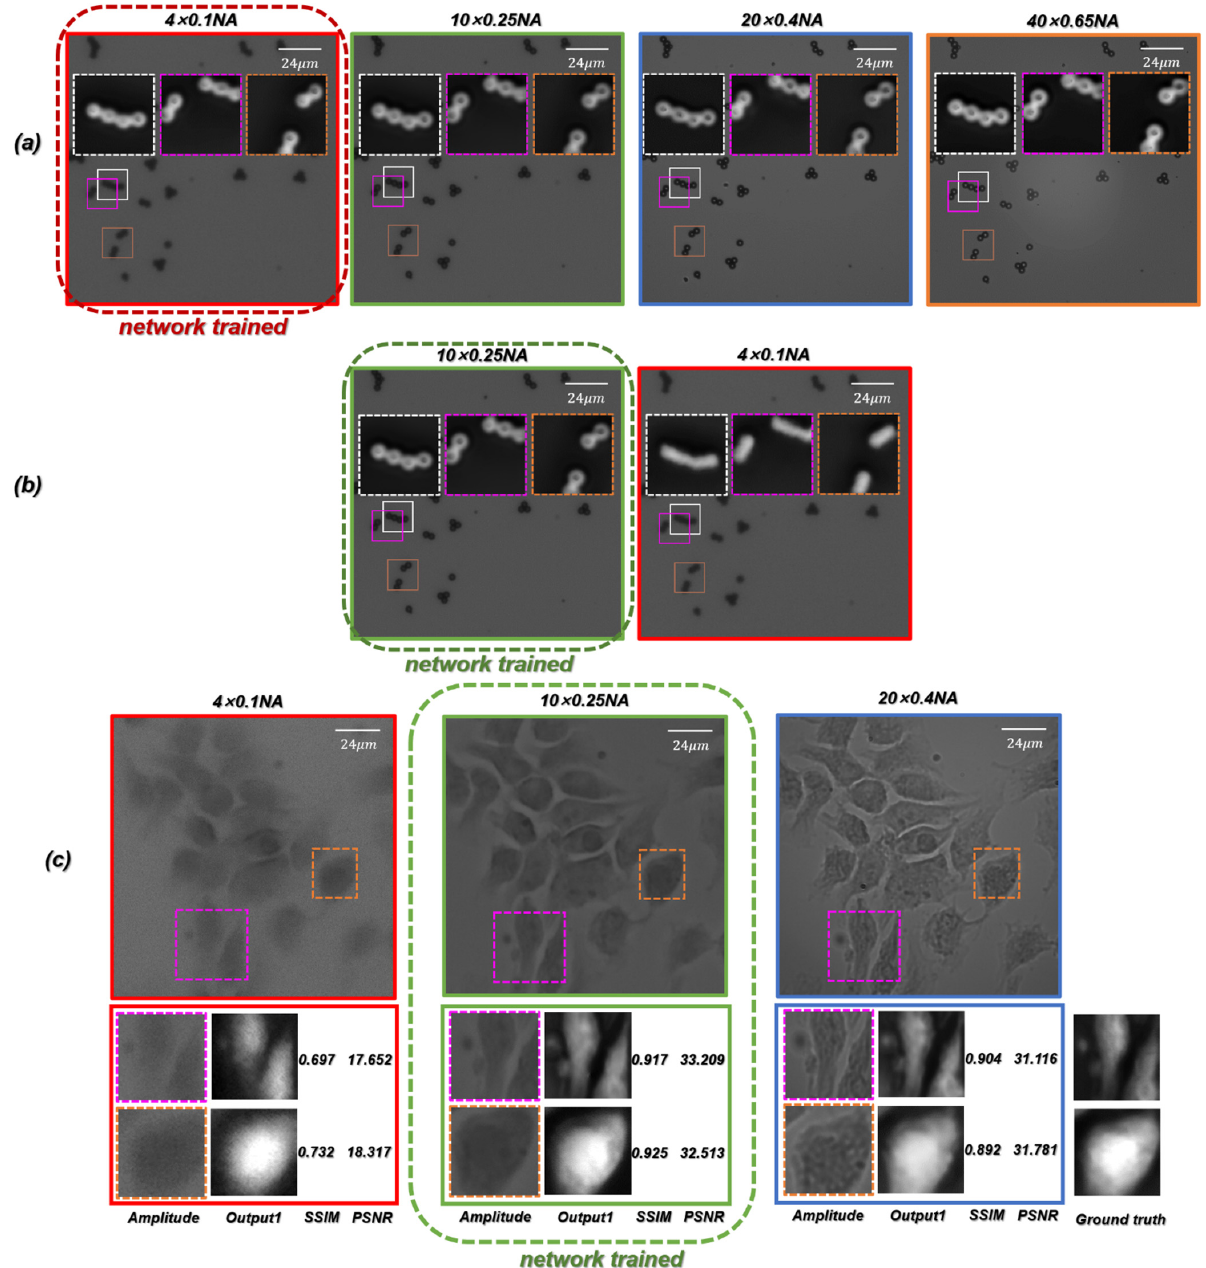
Figure 10. Test results of microscopic images captured by different NA objectives using the ContransGAN trained by microscopic images captured by a certain NA objective. ( a ) The network trained with the microscopic images under the 4 × /0.1 NA objective generated HR phase images of the microscopic images captured by the higher NA objective. ( b ) The network trained with the microscopic images under the 10 × /0.25 NA objective generated HR phase images of the microscopic images captured by the higher NA objective. ( c ) The network trained with the microscopic images under the 10 × /0.25 NA objective generated HR phase images of the microscopic images captured by the other NA objectives.